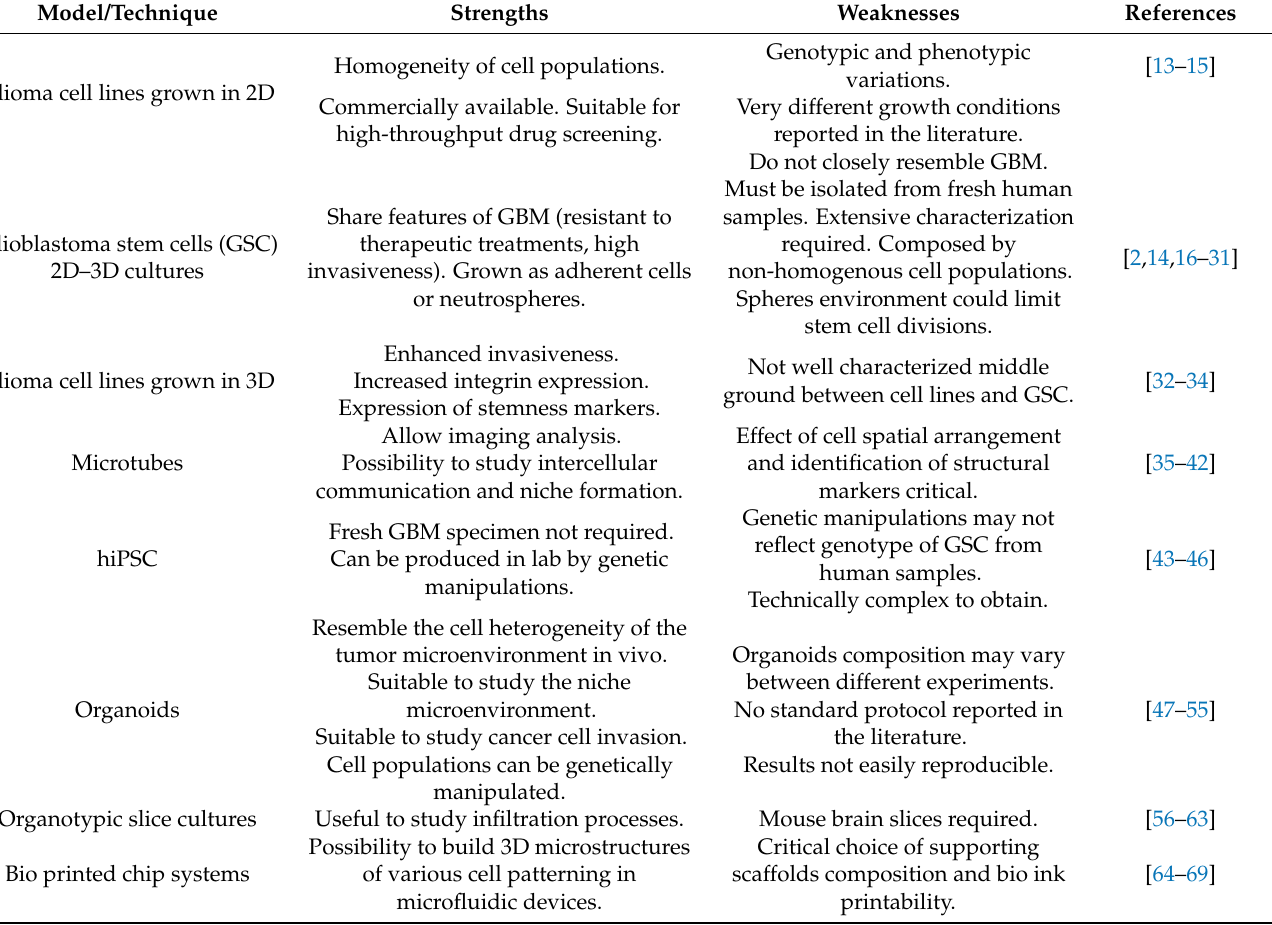
Table 1. Summary of the advantages and disadvantages of all the techniques cited in the text. Model/Technique Strengths Weaknesses